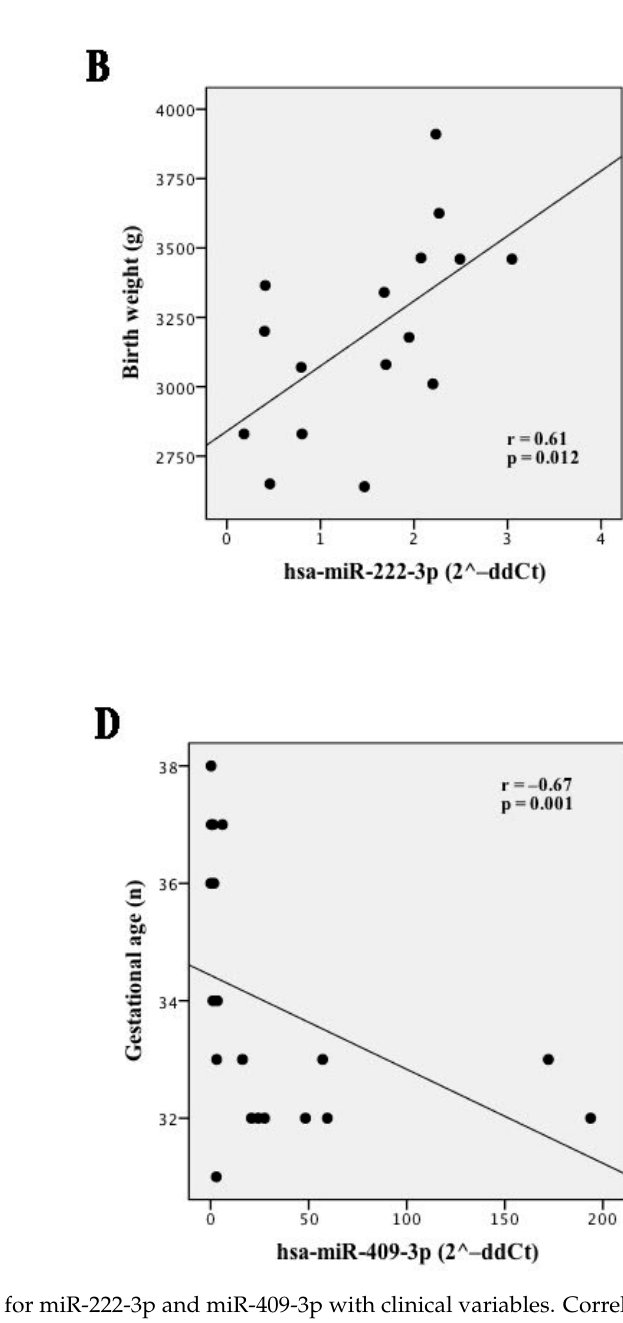
Figure 4. Correlation analyses for miR-222-3p and miR-409-3p with clinical variables. Correlation analyses between miR-222-3p and FPG ( A ) hsa-miR-222-3p and birth weight ( B ); hsa-miR-409-3p and FPG ( C ); and hsa-miR-409-3p and gestational age ( D ). Correlation analysis was performed in 24 samples (GDM, n = 12; NGT n = 12). Expression levels are reported as normalized 2 –ddCt values. Spearman R test was performed to evaluate r -values and p -values ( p <